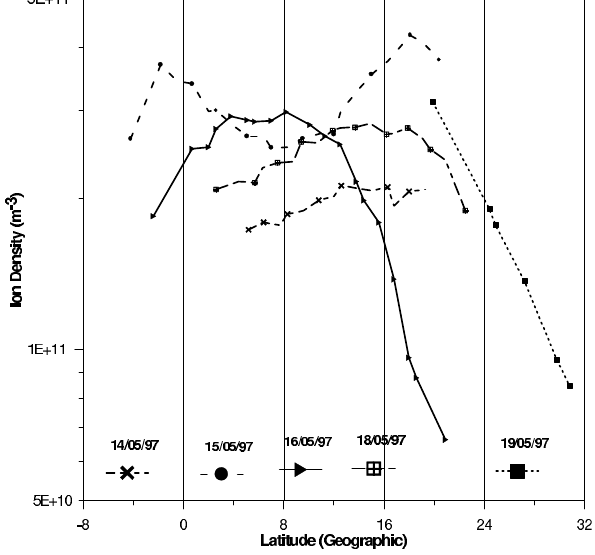
Fig. 3. Latitudinal variation of ion density observations made by the SROSS-C2 satellite during the period of storm II. The longitude range covered by each pass is given in Table